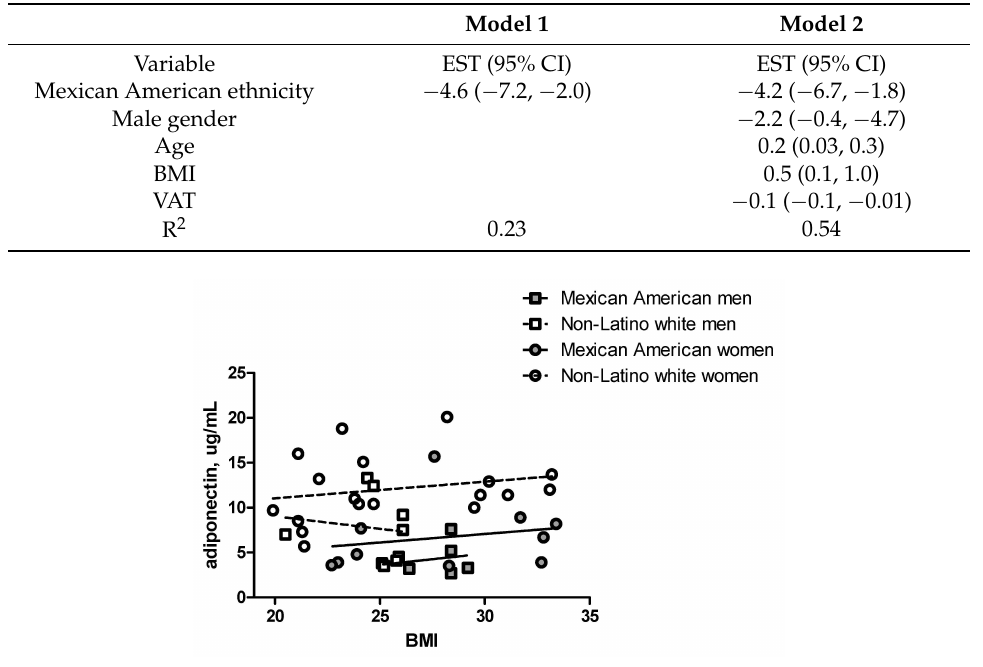
Figure 1. Differences in adiponectin concentrations between Mexican Americans and non-Latino Whites across BMI Ranges. Symbols represent adiponectin concentrations and BMI for Mexican American women ( ), men ( (cid:4) ), and non-Latino white women ( ), and men ( ˝ ). Lines represent (cid:35) linear regression lines for Mexican Americans (solid line) and non-Latino whites (dashed lines) with higher/longer lines representing women of each group. Differences in intercepts: p < 0.001 for women, p = 0.20 for